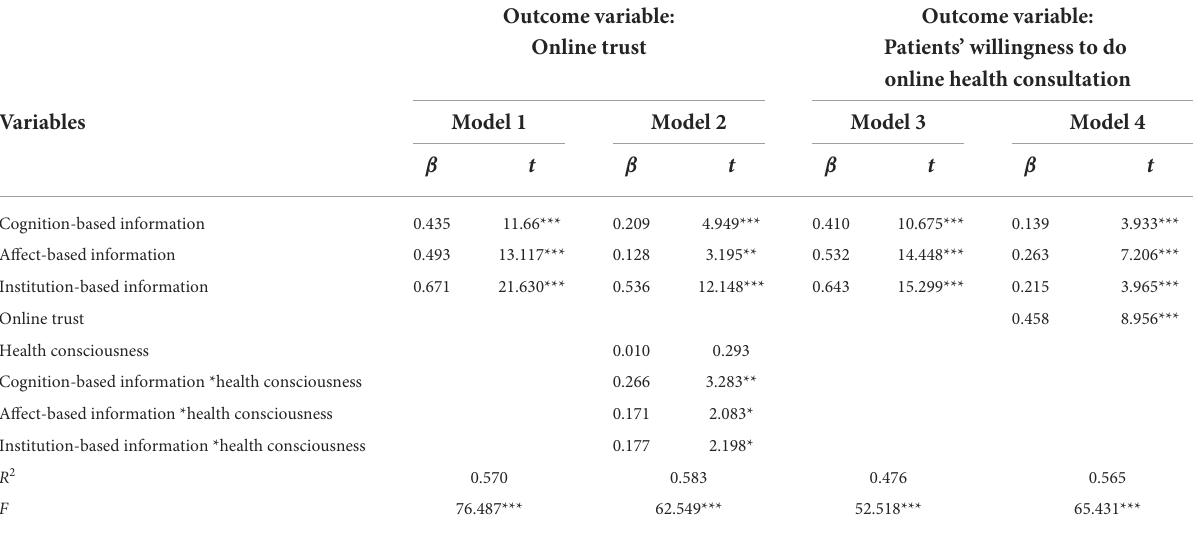
TABLE 3 The moderated mediating effect between online health platform information and patients’ willingness to do online health consultation.